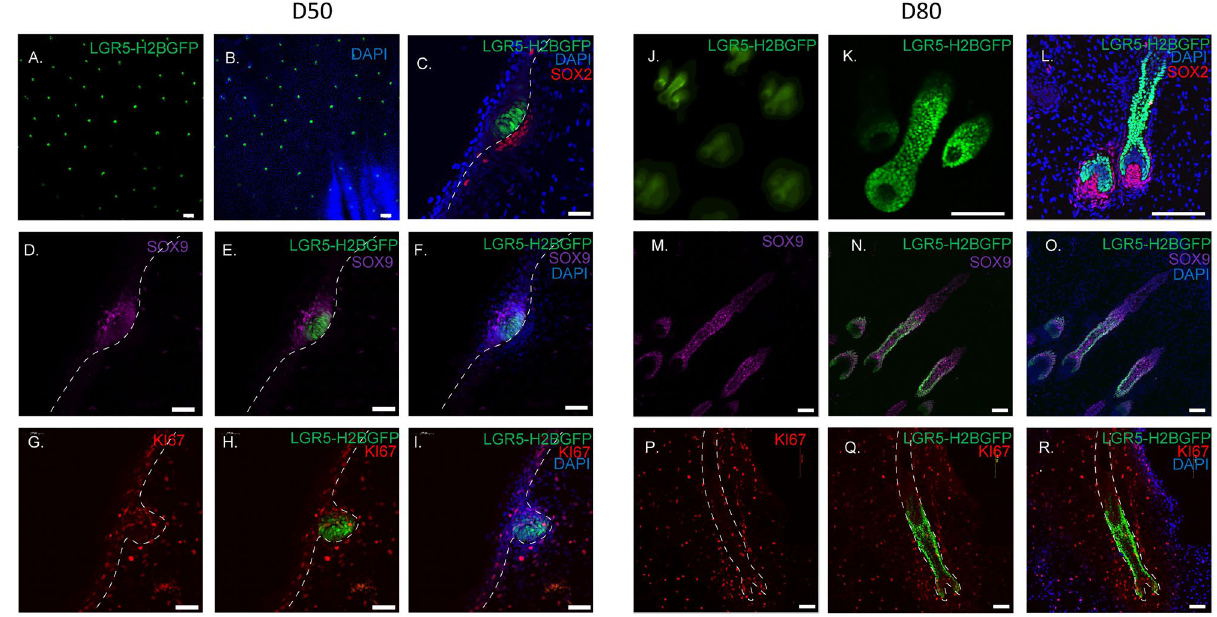
Figure 5. LGR5 is expressed early and late throughout developing porcine hair follicles. Fetal porcine skin at day 50 of gestation ( A – I ). ( A , B ) Whole mount confocal imaging showing patterning of LGR5 ( A ) and overlay with DAPI ( B ). ( C ) Cryosectioned immunostaining shows LGR5-H2BGFP cells throughout the hair germ, perpendicular to the basement membrane and adjacent to the developing dermal papillae marked by SOX2. Dashed lines demarcate the dermis/epidermis boundary and the location of the basal membrane. ( D – F ) Expression of SOX9 in relation to LGR5-H2BGFP showing LGR5 cells express low or no SOX9 in the placode. ( G – I ) Comparison of LGR5-H2BGFP and KI67 staining show little overlap, confirming our qPCR-data that the LGR5-H2BGFP cells are a slow-cycling population. ( J – R ) Day 80 porcine fetal skin. ( J ) Whole mount staining shows triplet pattern of follicular development. ( K , L ) LGR5-H2BGFP cells in the base of the follicle remain in close contact with the dermal papillae (SOX2) as they invaginate into the developing dermis. ( M – O ) LGR5- H2BGFP expression is found in the outer root sheath of the lower developing follicle, partially overlapping with SOX9 expression which is not limited to the outer root sheath. ( P – R ) KI67 shows that the few proliferating LGR5-H2BGFP cells (yellow) are found at the base of the hair follicle (dashed lines), adjacent to the dermal papillae. Scale bar represents 200 μM ( A , B ), 50 μM ( C – I ), or 100 μM ( K – R